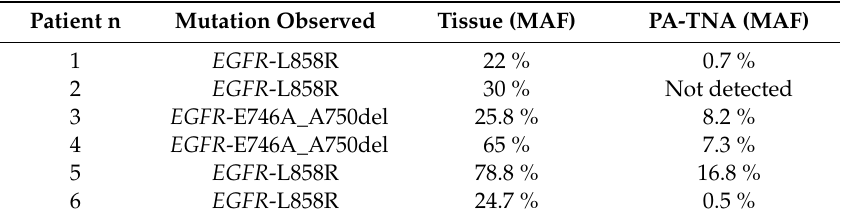
Table 3. Comparison of EGFR Detection in Tissue Biopsy and PA.